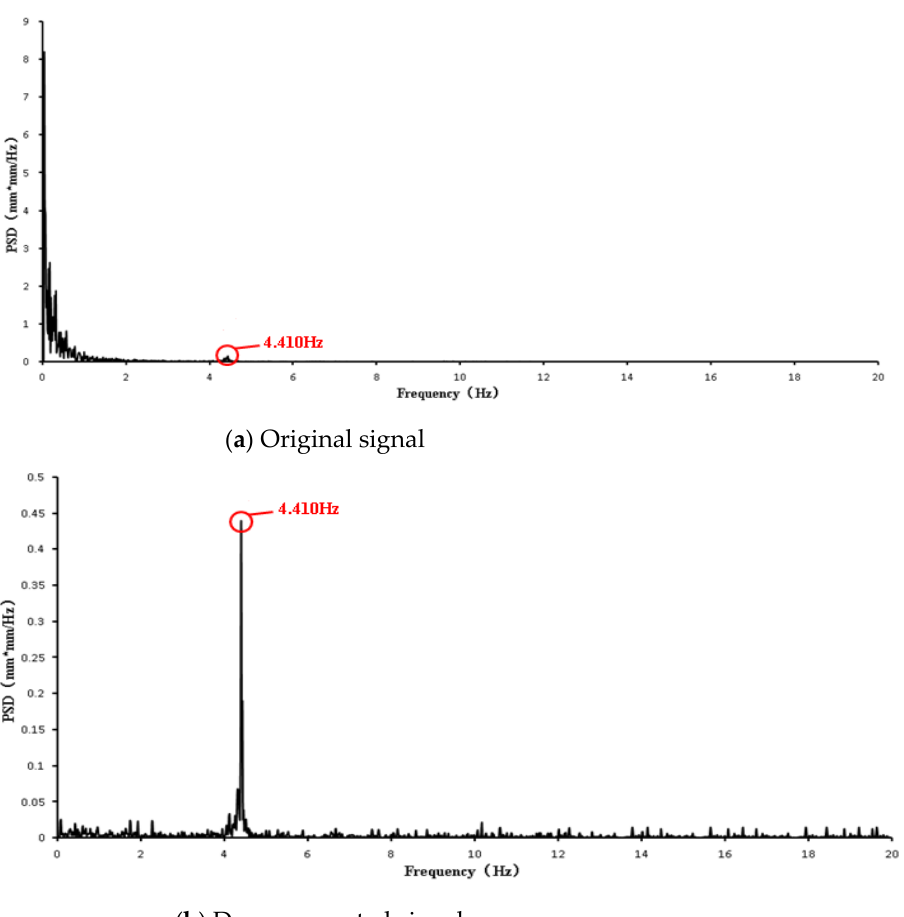
Figure 10. PSD function curves of two signals: Original and corrected.